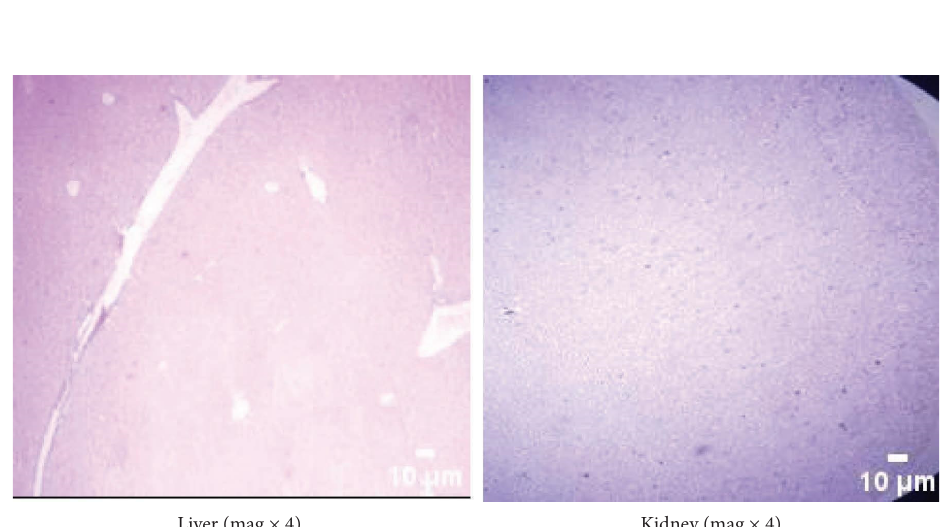
Figure 1: Histology of the liver and kidneys of control mice. Te liver and kidney showed no histological changes. (a) Liver (mag x4). (b) Kidney (mag x4).